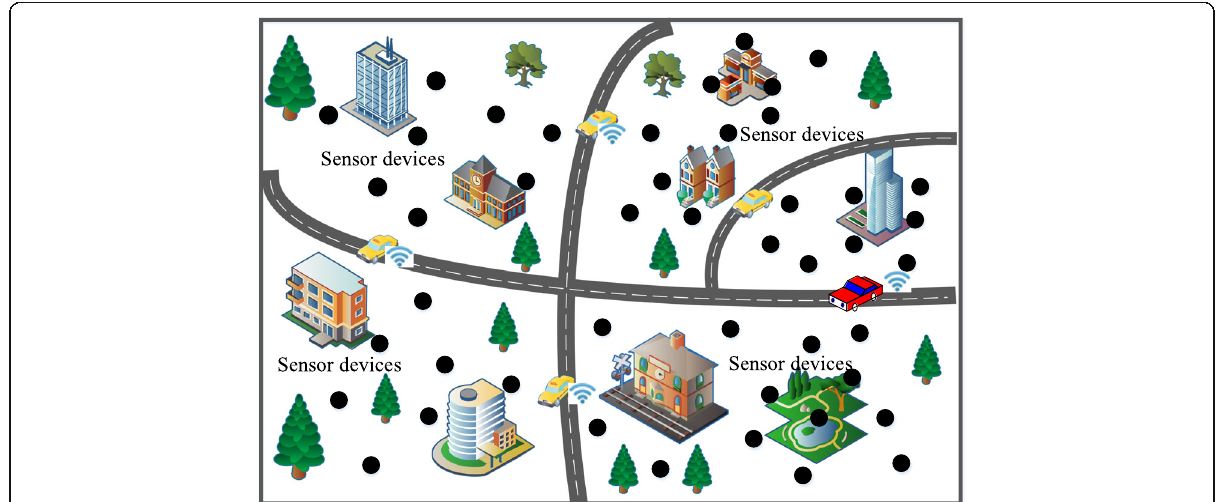
Fig. 1 The IoT devices in edge network for smart